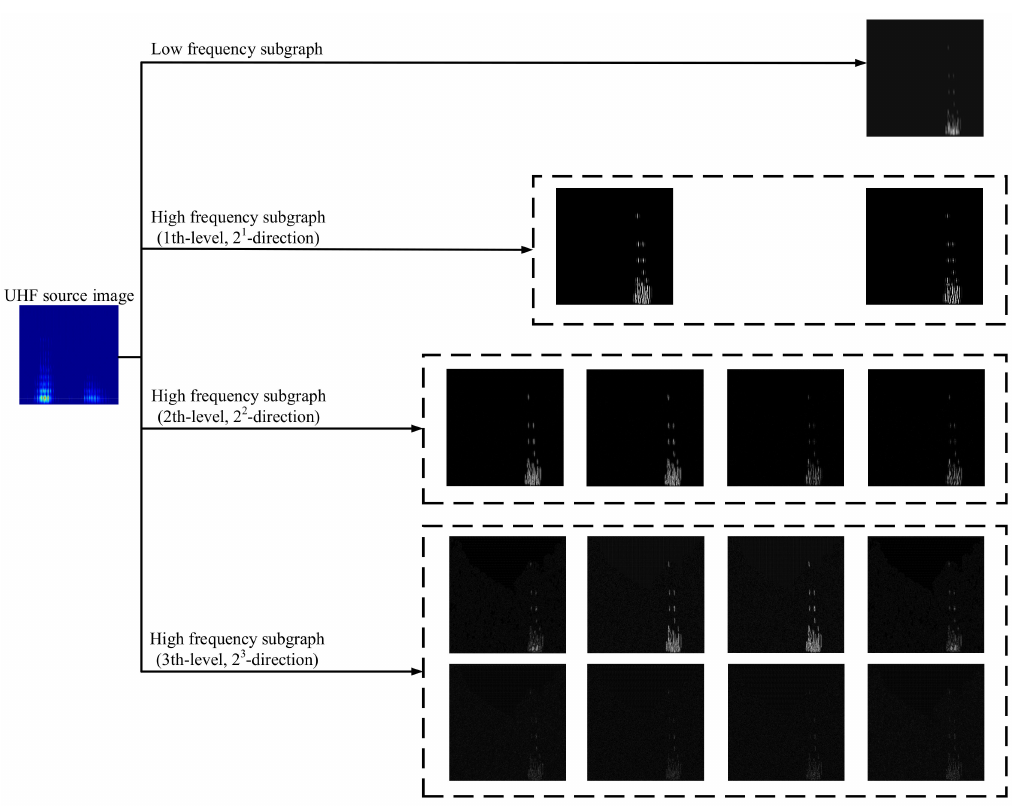
Figure 13. NSCT decomposition of the UHF PD